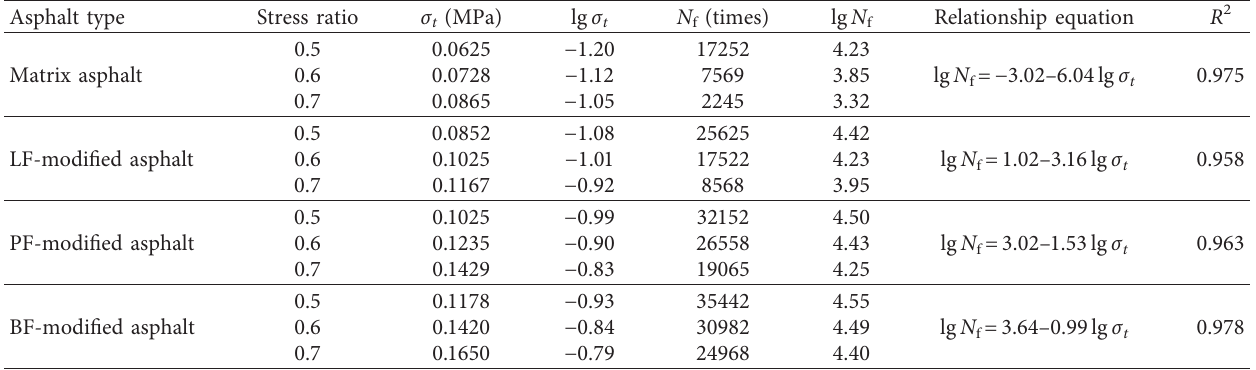
Table 9: Fatigue results of different asphalt mixtures.